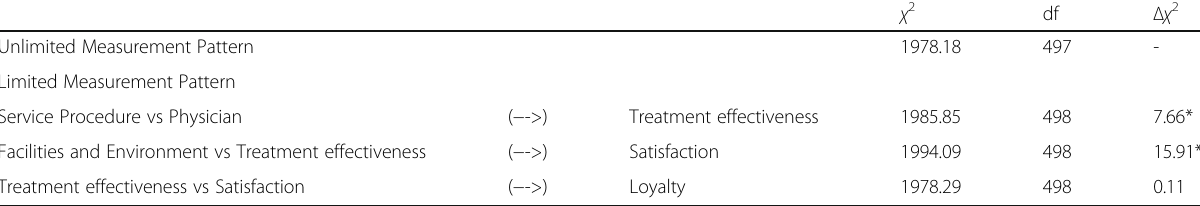
Table 5 Comparison of path